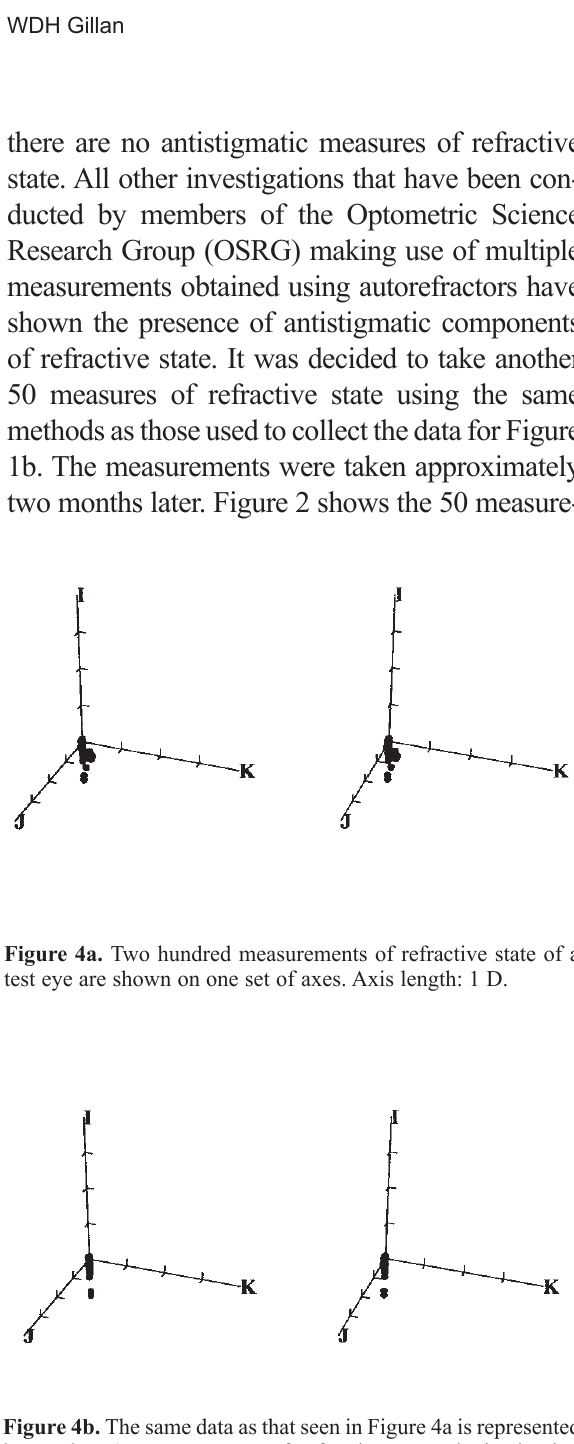
Figure 4b. The same data as that seen in Figure 4a is represented here. The 50 measurements of refractive state obtained using the ARK-700 autorefractor are excluded. A tight cluster is seen with little antistigmatic variation. Two possible outliers are seen positioned below (in this orientation) the primary cluster.